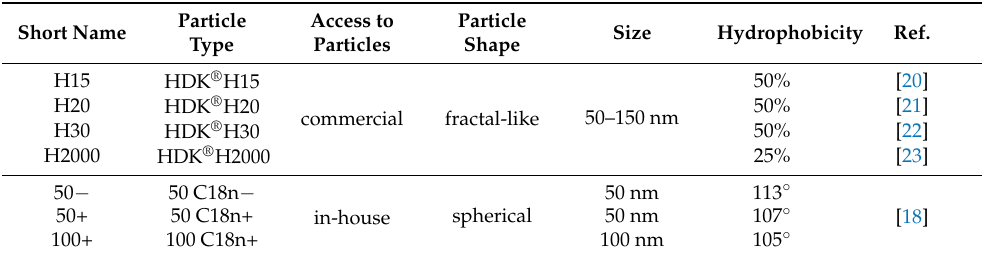
Table 2. Overview of nanoparticle types used in this work. The particle hydrophobicity is expressed either via the residual silanol content (% SiOH) or the contact angle ( ◦